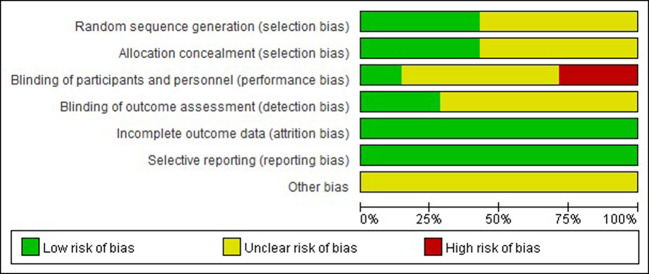
Risk of bias graph.